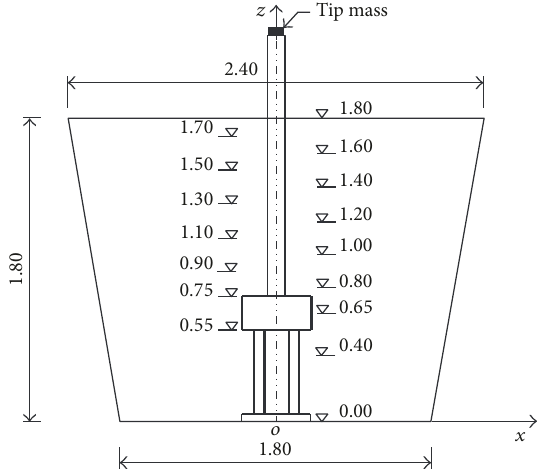
Figure 9: The 15 water levels considered in the tests; all dimensions are in